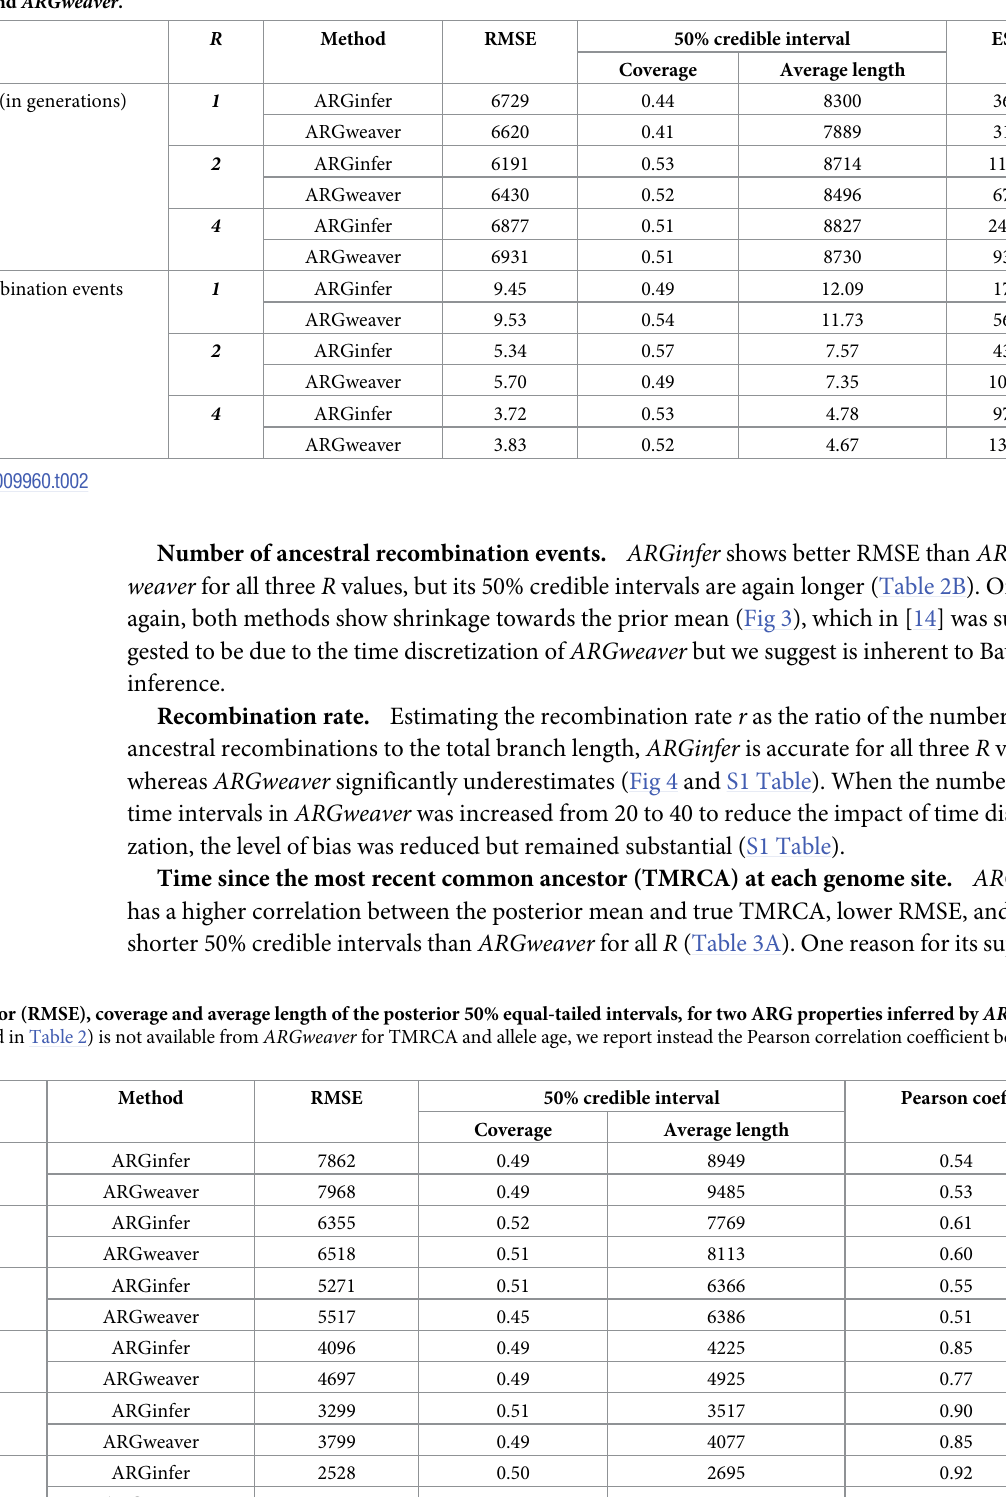
Table 2. The root mean square error (RMSE), coverage and average length of the posterior 50% equal-tailed intervals, and Effective Sample Size (ESS) for two ARG properties inferred by ARGinfer and ARGweaver .